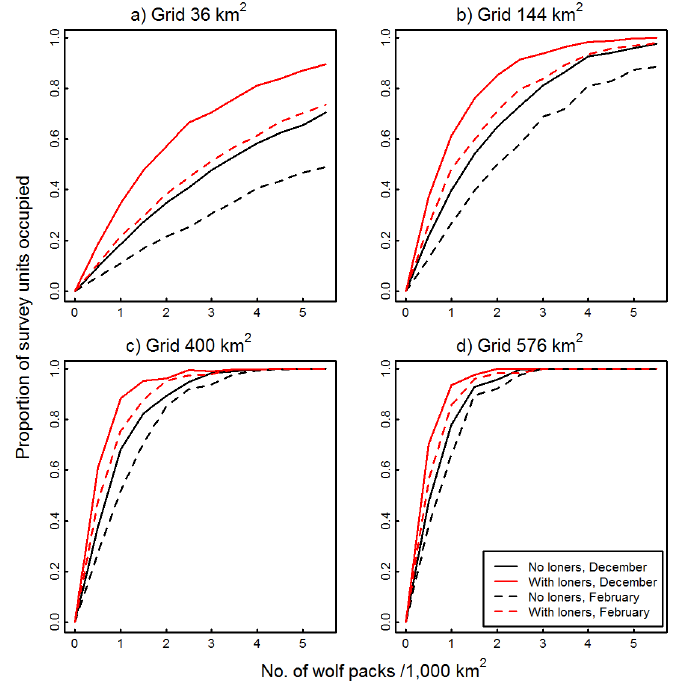
Figure 3. Effects of the presence of lone wolves on occupancy–abundance relationships. Occupancy-abundance relationships were estimated from the proportion of survey units in which wolf tracks were detected during simulated aerial surveys as a function of wolf pack density (No. packs/1,000 km 2 ). Wolf movements were simulated using December or February step length and turn angle distributions from 2-hour GPS locations from 11 wolves, northeastern Alberta, Canada, 2006–2008. Lone wolves movements were simulated using the empirical distributions from December or February but without constraining travel paths to occur within territory boundaries. Simulations were run for four grids: (a) 36 km 2 , (b) 144 km 2 , (c) 400 km 2 , and (d) 576 km 2